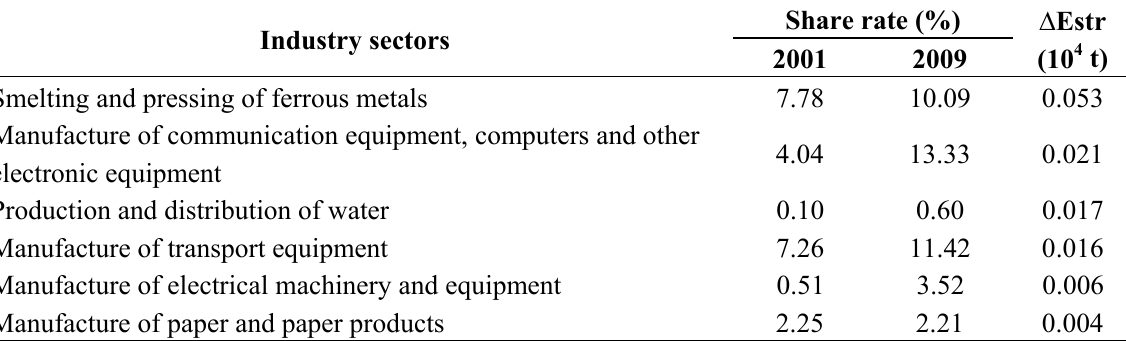
Table 7. The top six contributing sub-sectors with related to the structure effect and share rate of NH -N changes during 4